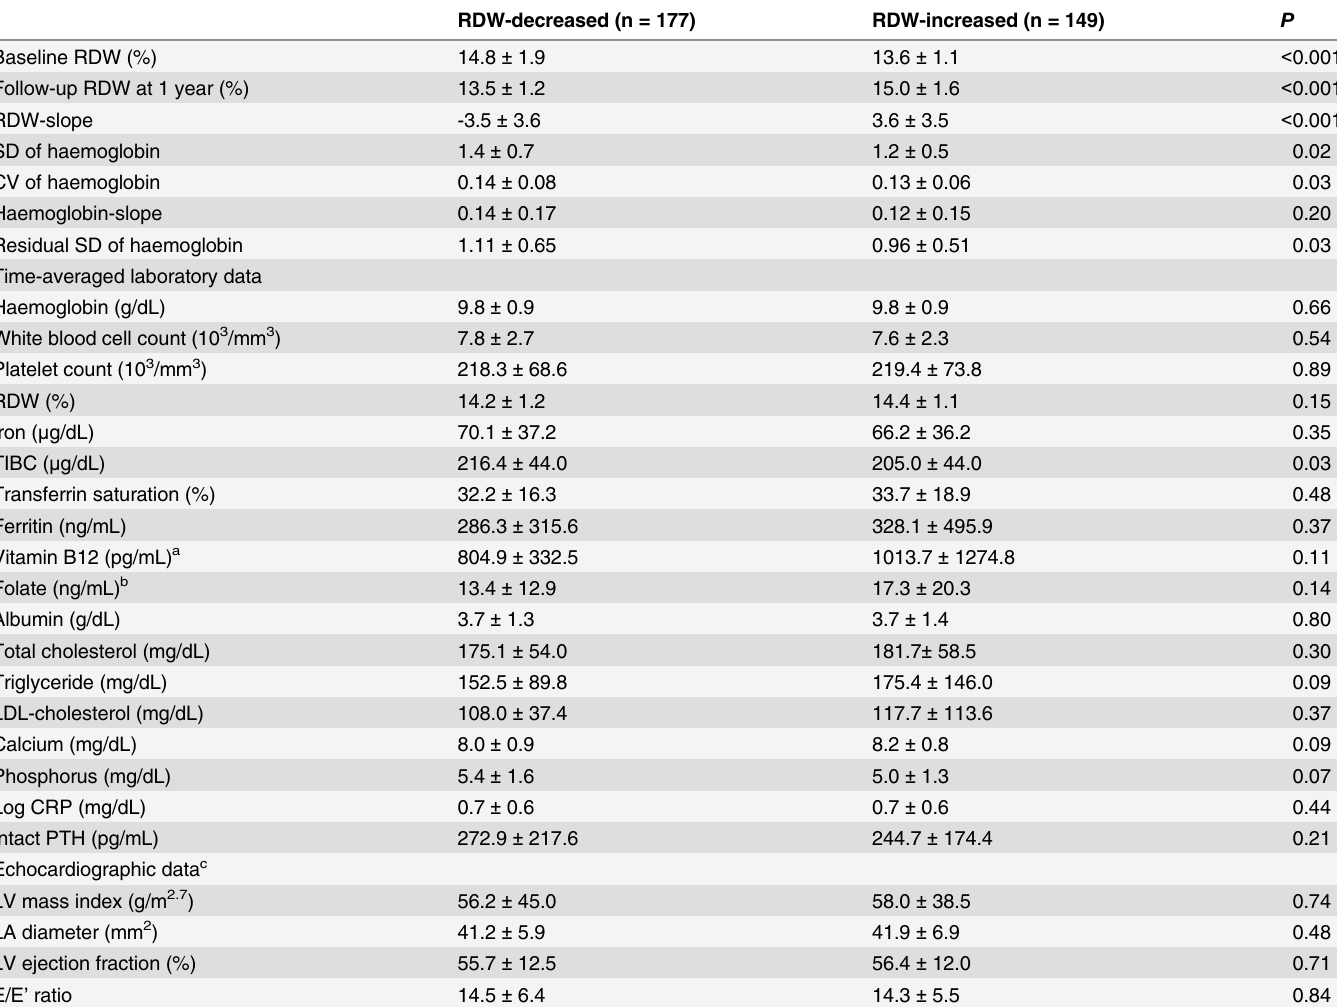
Table 2. Laboratory and echocardiographic